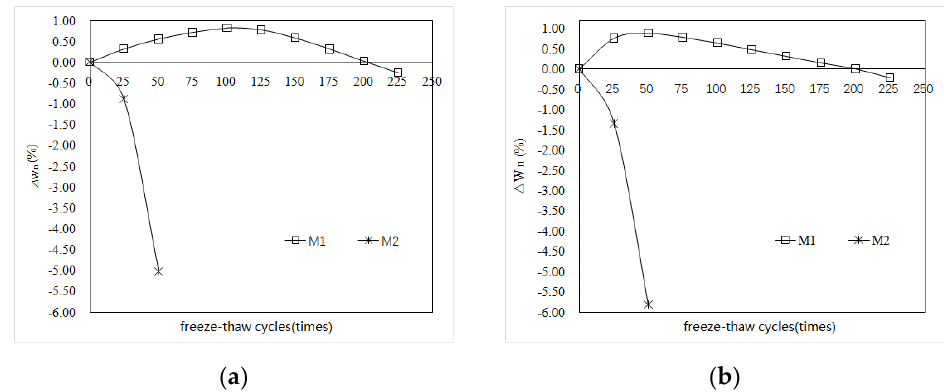
Figure 3. Mass change in MKPC mortar and P.O mortar samples in freeze-thaw environments. ( a ) Water freeze-thaw environment; ( b ) 5% Na 2 SO 4 freeze-thaw environment.